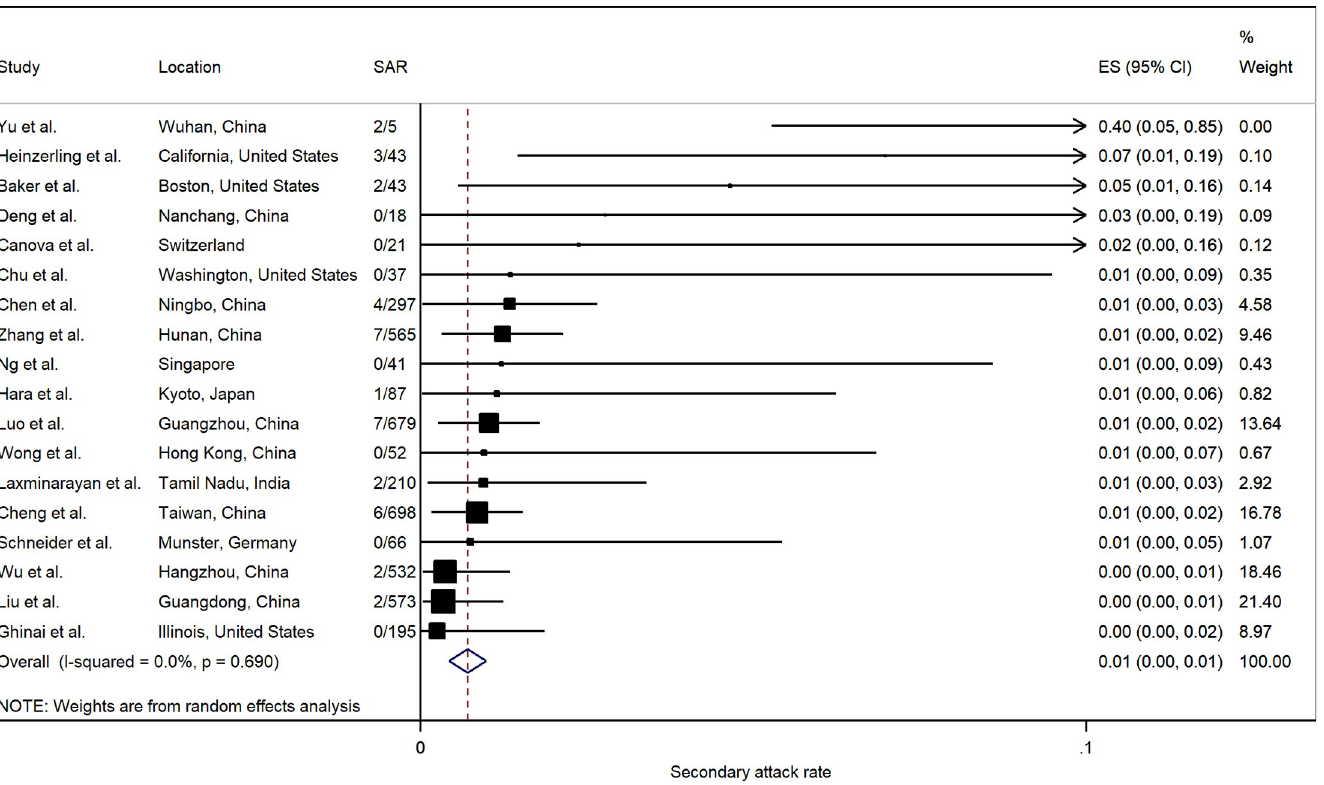
Fig 5. Forest plot of household transmission risk by adult and children close contact. RR is the estimated risk ratio, with 95% confidence intervals (CI). I-squared is the percentage of between-study heterogeneity that is attributable to variability in the true effect, rather than sampling variation.